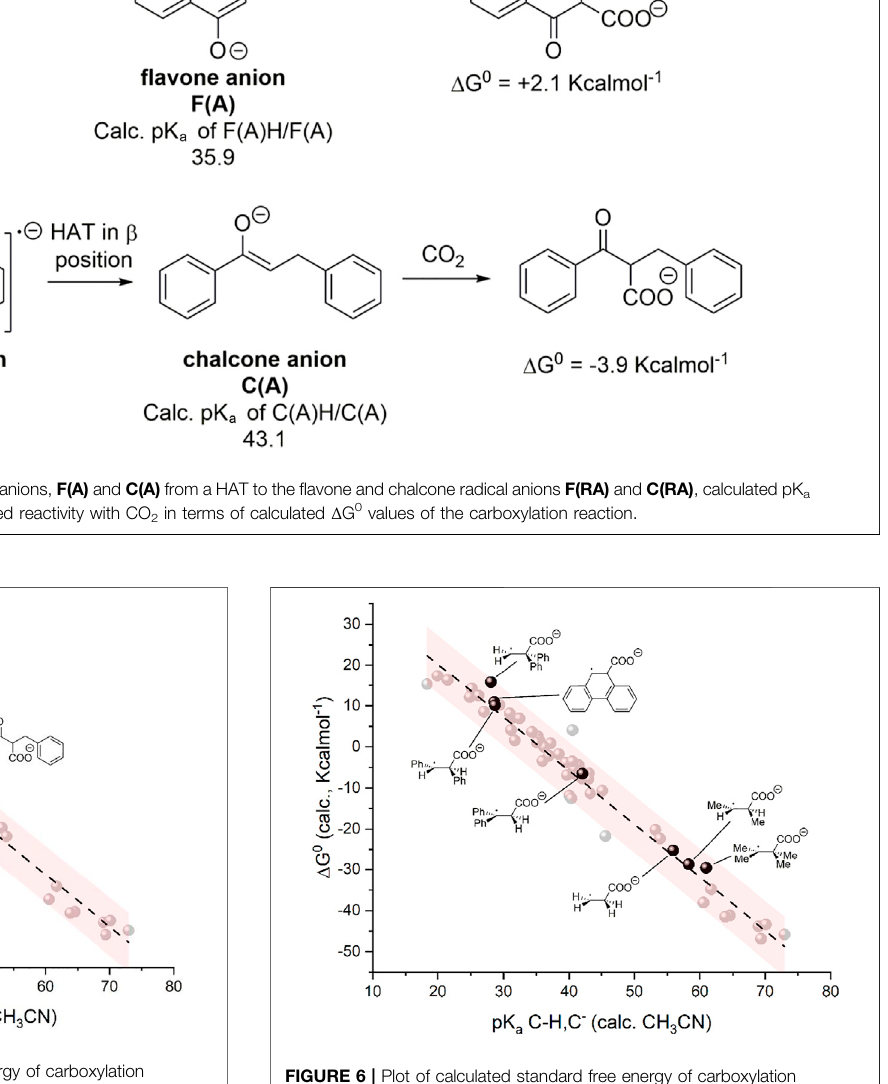
FIGURE 6 | Plot of calculated standard free energy of carboxylation ( Δ G 0 1 ) vs. calculated pK a of the CH/C − couples. The black dots refer to the products upon carboxylation from radical anions of alkenes. The light gray dots indicate the same 50 organic molecules reported in Chart 1 and plotted in Figure 1